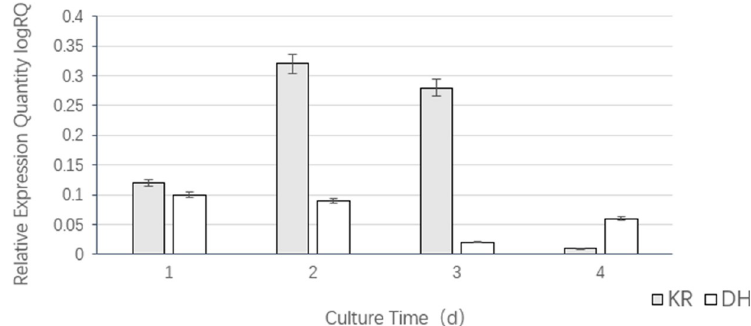
Fig 6. Relative transcription levels of kr and dh genes in transformed